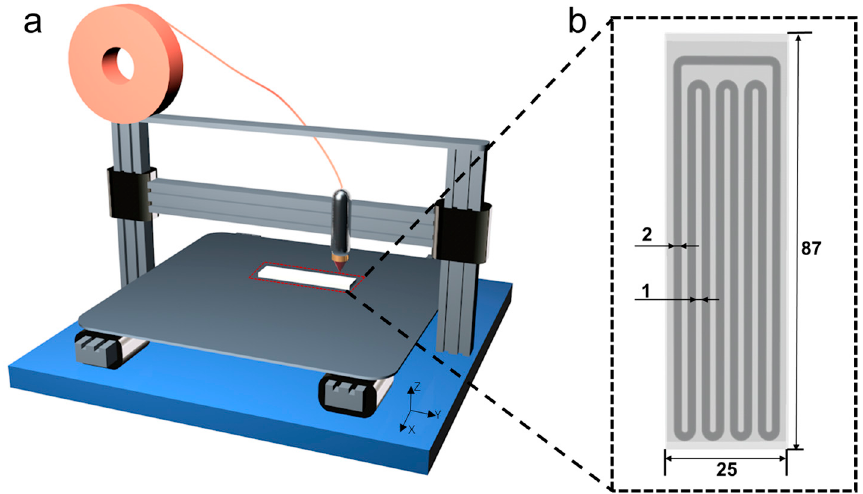
Figure 1. Schematic diagram of ( a ) the 3D printing process and ( b ) the structure of the 3D-printed FOHP.